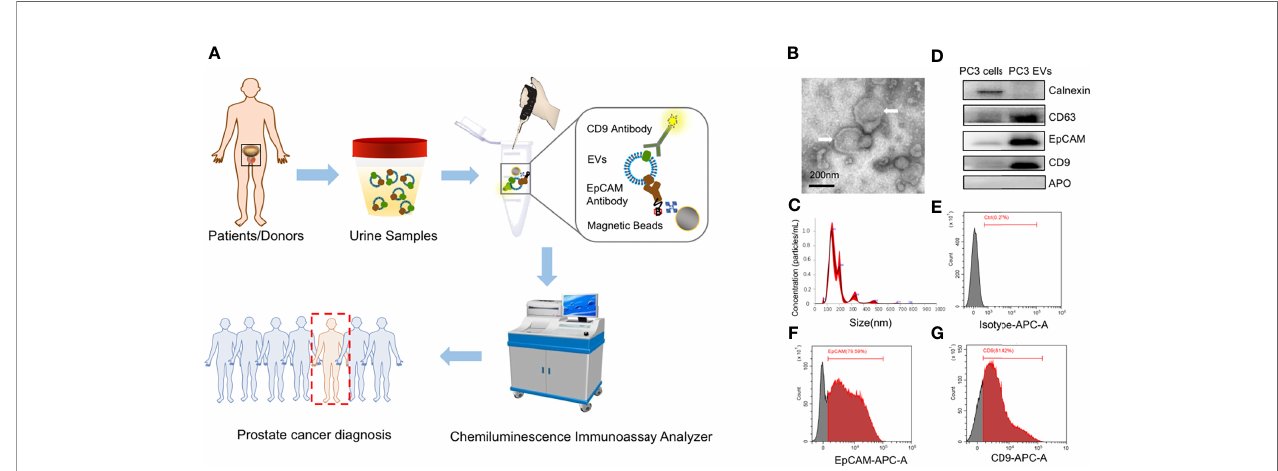
FIGURE 1 | The scheme of work fl ow for urinary EpCAM-CD9-positive extracellular vesicle (uEV EpCAM-CD9 ) detection. (A) EpCAM-CD9-positive EVs diffused in urine are bound with acridinium ester (ACE)-labeled anti-CD9 antibodies and captured by magnetic microbeads labeled anti-EpCAM antibodies. After incubation for 60 min, uEV EpCAM-CD9 binding with magnetic microbeads can be easily isolated under an external magnetic fi eld and quantitatively analyzed by a chemiluminescent immunoassay analyzer to diagnose prostate cancer. (B) TEM images of EVs isolated by ultracentrifugation (white arrow). (C) EVs are characterized by NTA. (D) The expression of CD63, CD9, EpCAM, calnexin, and APO in PC3 cell lysates and the EV fraction from PC3 by WB analysis. (E – G) Flow cytometry assay identi fi ed that approximately 80% of EVs released by PC3 carried EpCAM and CD9. EpCAM, epithelial cell adhesion molecule; uEVEpCAM-CD9, urinary EpCAM-CD9-positive extracellular vesicles; EVs, extracellular vesicles; ACE, acridinium ester; TEM, transmission electron microscope; NTA, nanoparticle tracking analysis; WB, western